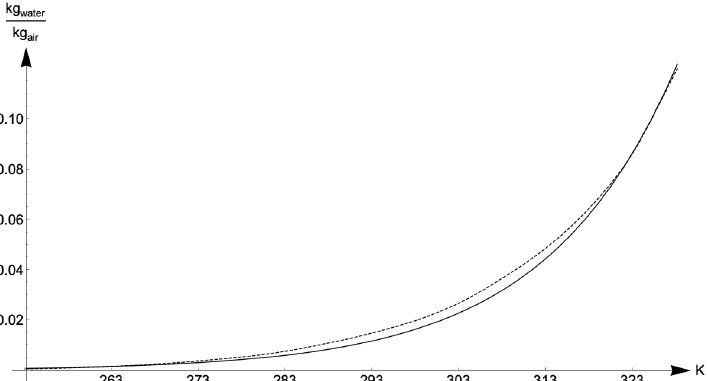
Figure 3. Plot of the saturation humidity function U s ( T ) , T is expressed in Kelvin. The dotted line represents the empirically measured values, the continuous line is the exponential